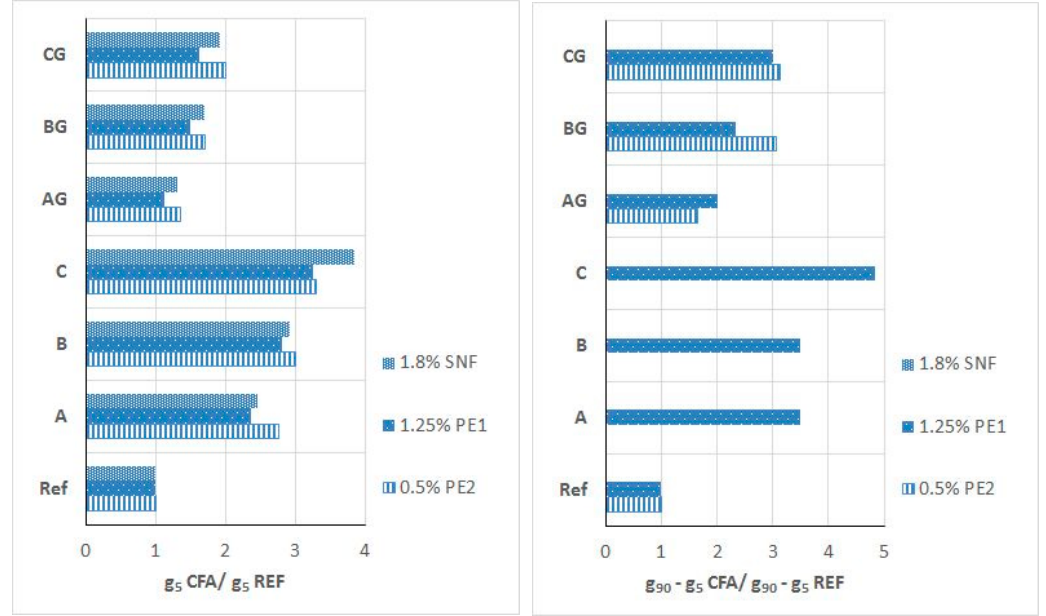
Figure 17. Relative effect of CFA presence on initial yield value g (g5) and yield value g increase in time (g90–g5) of mortars in respect of reference mortars without CFA. (Mortars with SNF or PE1 or PE2 - ½ of recommended maximum dosage, w/b = 0.45).